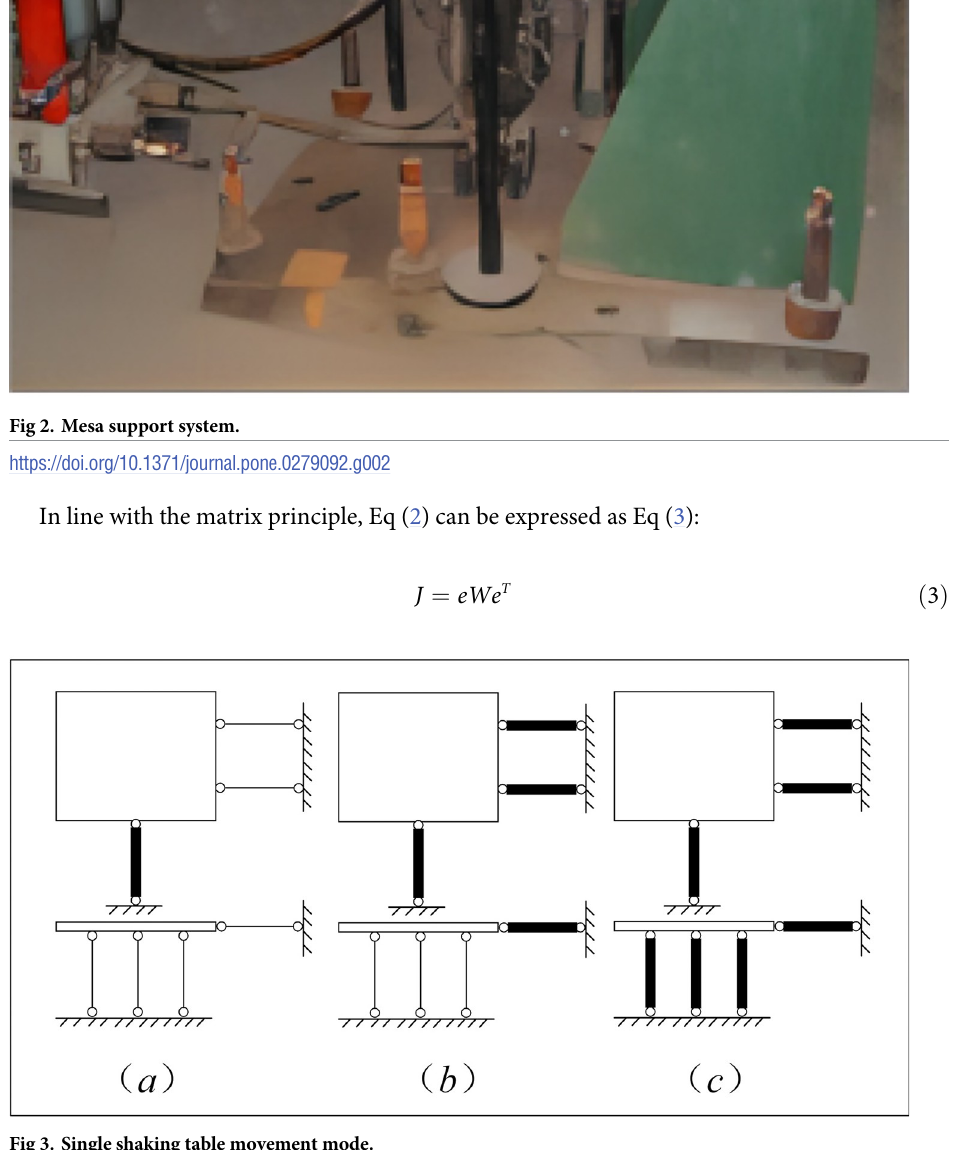
Fig 3. Single shaking table movement